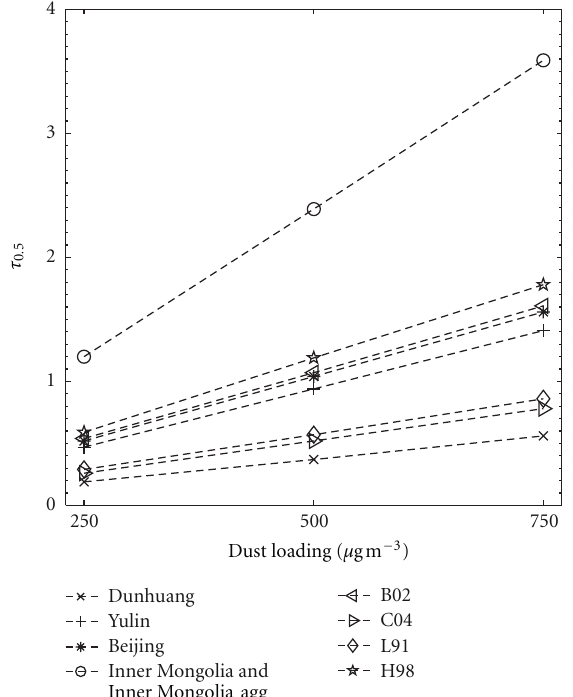
Figure 5: Dust optical depth at 0.5 μ m ( τ 0 . 5 ) computed for all dust cases at loadings of M = 250, 500, and 750 μ g m − 3 .